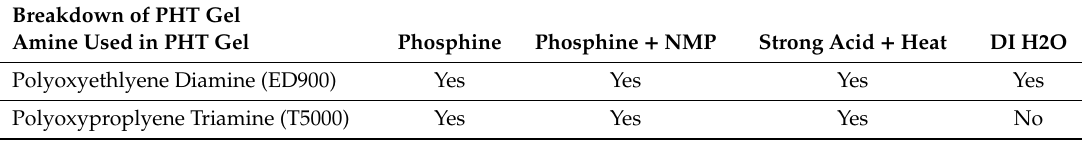
Table 3. Comparison of polyhexahydrotriazine (PHT) gel